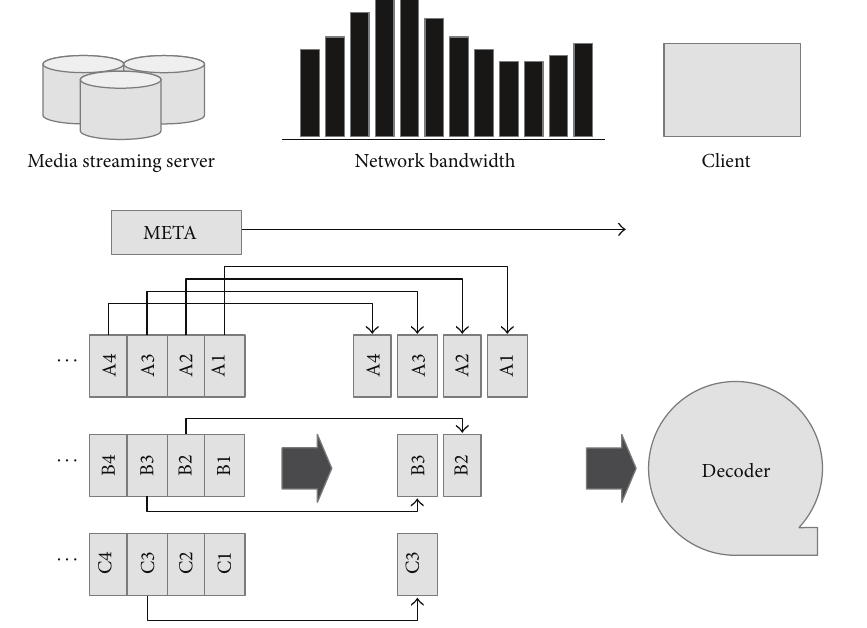
Figure 3: Scalable streaming scheme.